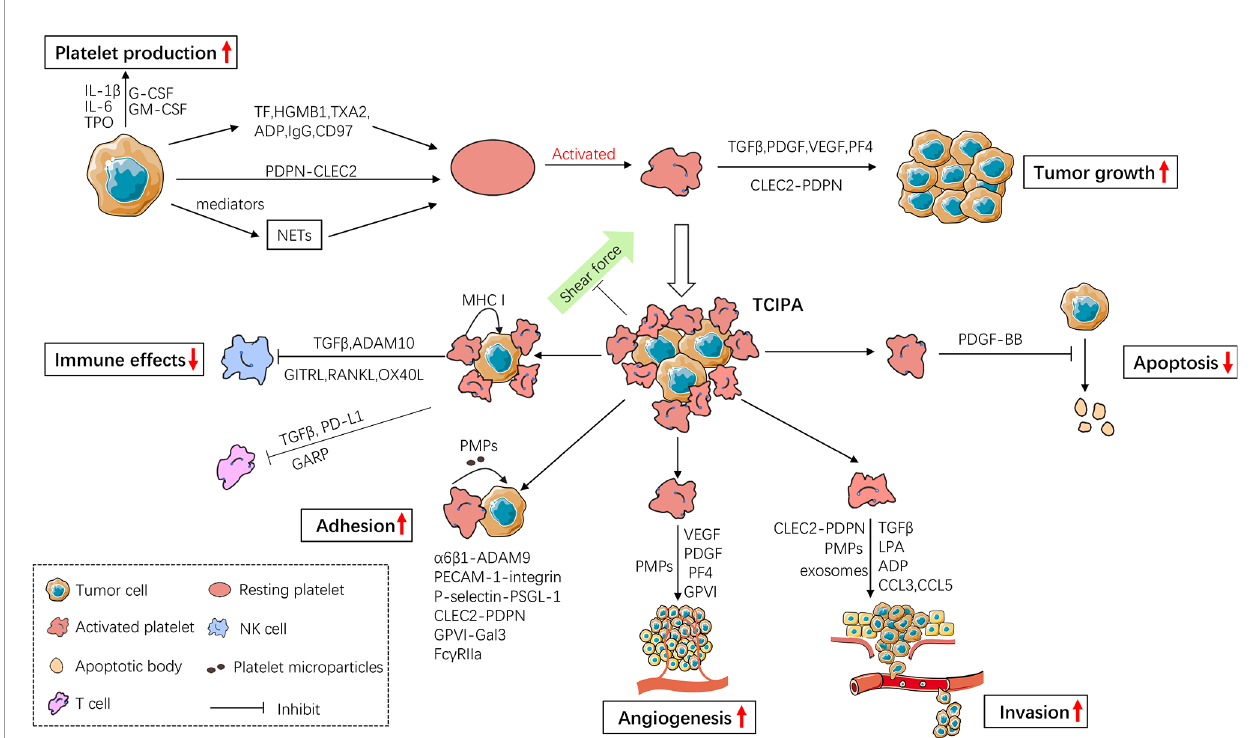
FIGURE 1 | The bidirectional interaction between cancer cells and platelets. Cancer cells promote platelet production and activation, while activated platelets release a number of mediators to facilitate tumor growth and cancer cell metastasis. Activated platelets prevent circulating cancer cells (CTCs) from shear fl ow, immune surveillance and apoptosis, thus enhancing CTC survival in circulation. They also facilitate CTC adhesion, angiogenesis and invasion thereby enhancing metastasis. IL-1 b , Interleukin-1 b ; IL-6, Interleukin-6; TPO, thrombopoietin; G-CSF, Granulocyte- Colony-Stimulating Factor; GM-CSF, Granulocyte-Macrophage-Colony- Stimulating Factor; TF, Tissue Factor; HGMB1, High-Mobility Group Box1; TXA2, Thromboxane A2; IgG, immunoglobulin G; PDPN, Podoplanin; CLEC2, C-type lectin receptor type 2; NETs, Neutrophil Extracellular Traps; TGF b , Transforming Growth Factor b ; PDGF, Platelet-Derived Growth Factor; VEGF, Vascular Endothelial Growth Factor; PF4, Platelet Factor 4; TCIPA, Tumor Cell-Induced Platelet Aggregation; MHC I, MHC class I; ADAM10, Disintegrin And Metalloproteinase Domain- Containing Protein 10; GITRL, Glucocorticoid-Induced TNF Receptor-Related Ligand; RANKL, Receptor Activator of NF- k B Ligand; OX40L, Oxford 40 Ligand; GARP, Glycoprotein A Repetitions Predominant; PD-L1, Programmed Cell Death-Ligand 1; PMPs, Platelet Microparticles; PECAM-1, Platelet-Endothelial Cell Adhesion Molecule-1; PSGL-1, P-selectin Glycoprotein